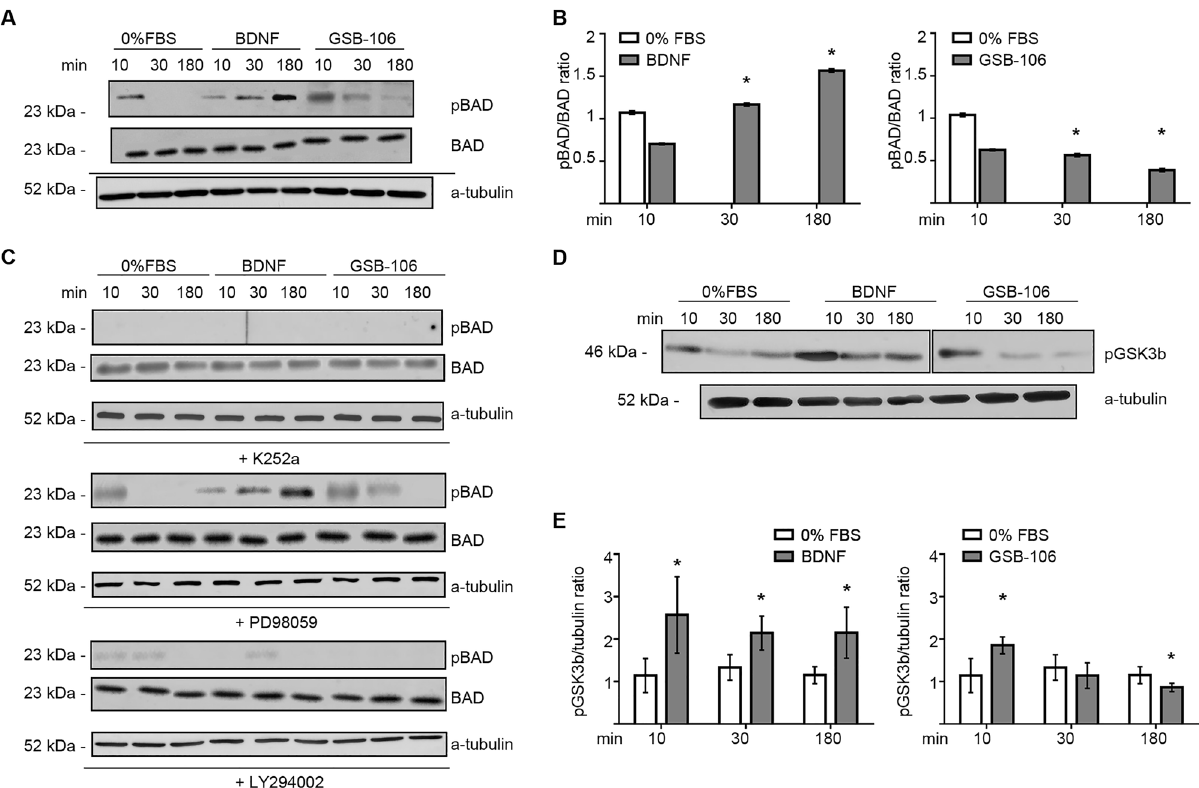
Figure 5. GSB-106-induced neuroprotection involves the BAD and GSK3β proteins. ( A ) GSB-106 activates Bad phosphorylation. SH-SY5Y cells were incubated in serum-free culture medium (“0% FBS”) with or without BDNF (~ 1 nmol) or GSB-106 (100 nmol) for 10 min, 30 min, or 180 min. Blots were first probed with anti-phosphorylated BAD (pBAD) antibody and then reprobed with anti-BAD antibody, anti-a-tubulin antibody. The figure shows data from one independent experiment (n = 3; the original blots are shown in the Supplementary Information file). ( B ) The ratio of signal derived from phosphorylated BAD over BAD bands was calculated (n = 3; *p < 0.05 in relation to “0% FBS”; Wilcoxon t -test). ( C ) SH-SY5Y cells in serum-free culture medium (“0% FBS”) with or without BDNF (~ 1 nmol) or GSB-106 (100 nmol) were also pre incubated with or without K252a (500 nmol, 60 min), LY294002 (50 µmol, 60 min) or PD98059 (50 µmol, 60 min). The figure shows data from one independent experiment (n = 2; the original blots are shown in the Supplementary Information file). ( D ) SH-SY5Y cells were incubated in serum-free culture medium (“0% FBS”) with or without BDNF (~ 1 nmol) or GSB-106 (100 nmol) for 10, 30, 180 min. Blots were first probed with anti-pGSK-3β antibody and then were reprobed with anti-a-tubulin antibody. The figure shows data from one independent experiment (n = 3; the original blots are shown in the Supplementary Information file). ( E ) The ratio of signal derived from p-GSK-3β over a-tubulin bands was calculated (n = 3; *p < 0.05 in relation to corresponding “0% FBS”; Wilcoxon t